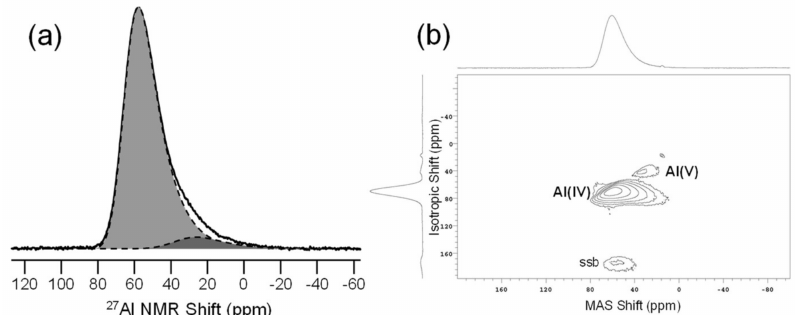
Figure 6. 27 Al NMR data for a glass with composition 24CaO-26.3Al 2 O 3 -49.7SiO 2 [44]. ( a ) 27 Al MAS NMR spectrum measured at 16.4 T, with data in bold line and fitting of Al(IV) and Al(V) polyhedra denoted by dashed lines and filled curves; ( b ) 27 Al 3QMAS NMR spectrum obtained at 16.4 T, with Al(IV) and Al(V) peaks marked. A very small signal from Al(VI) in the zirconia rotor (background) is also seen in the upper right of the contours. Plots to the top and left represent projections onto the MAS and isotropic shift axes, respectively.